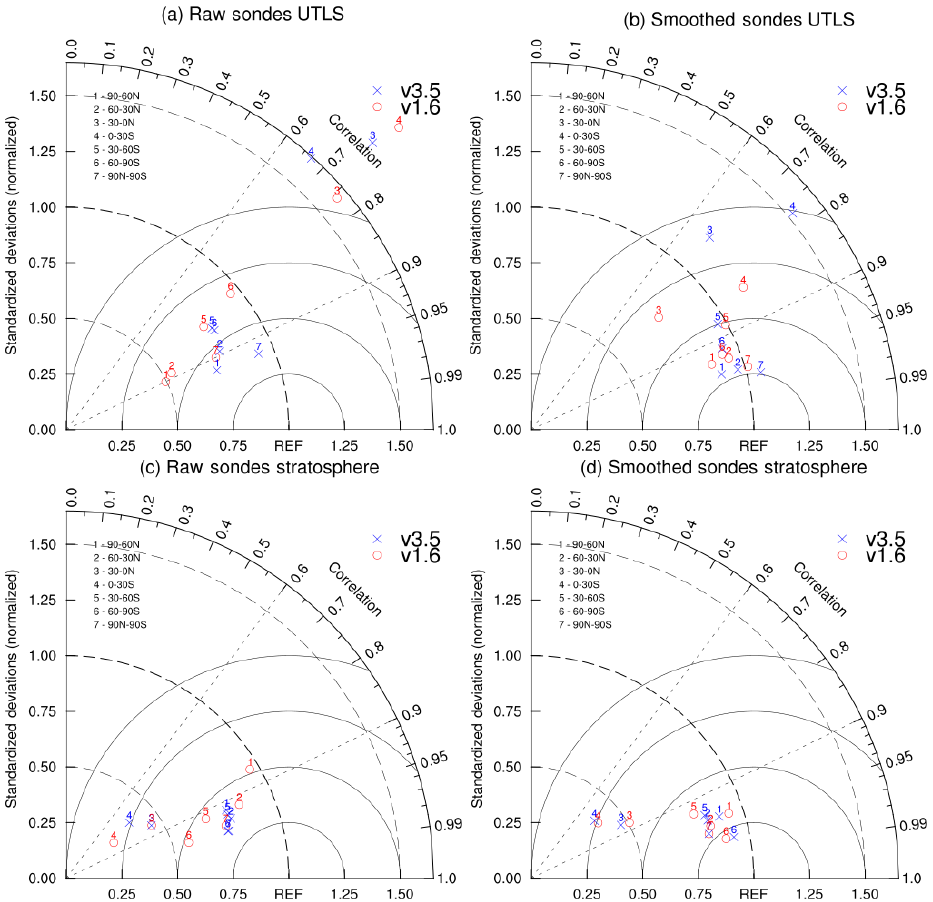
Figure 5. Taylor diagrams for (a, b) UTLS columns and (c, d) stratospheric columns. (a, c) Raw sonde data, (b, d) smoothed sonde data. Red circles indicate v1.6; blue crosses indicate v3.5. Table 2. Biases (%) between sondes and SOFRID retrievals with corresponding RMSDs (%). Values between brackets correspond to smoothed sonde data. Significant biases (bias > RMSD) are in bold